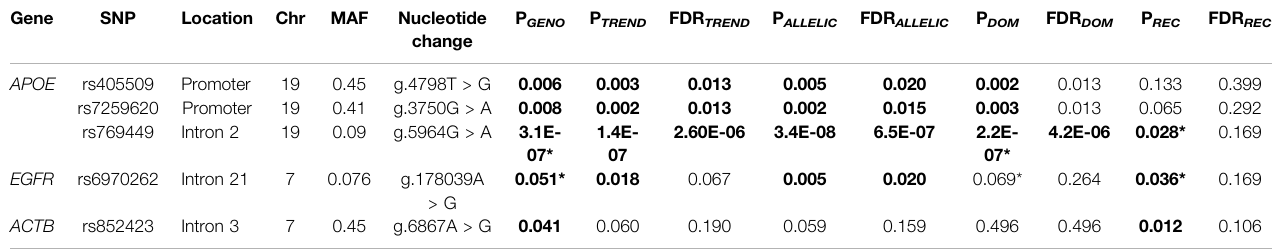
TABLE 1 | Association analysis of APOE , EGFR , and ACTB SNPs with AD risk among PwAD ( N (cid:2) 103) and non-demented controls ( N (cid:2) 146). Gene SNP Location Chr